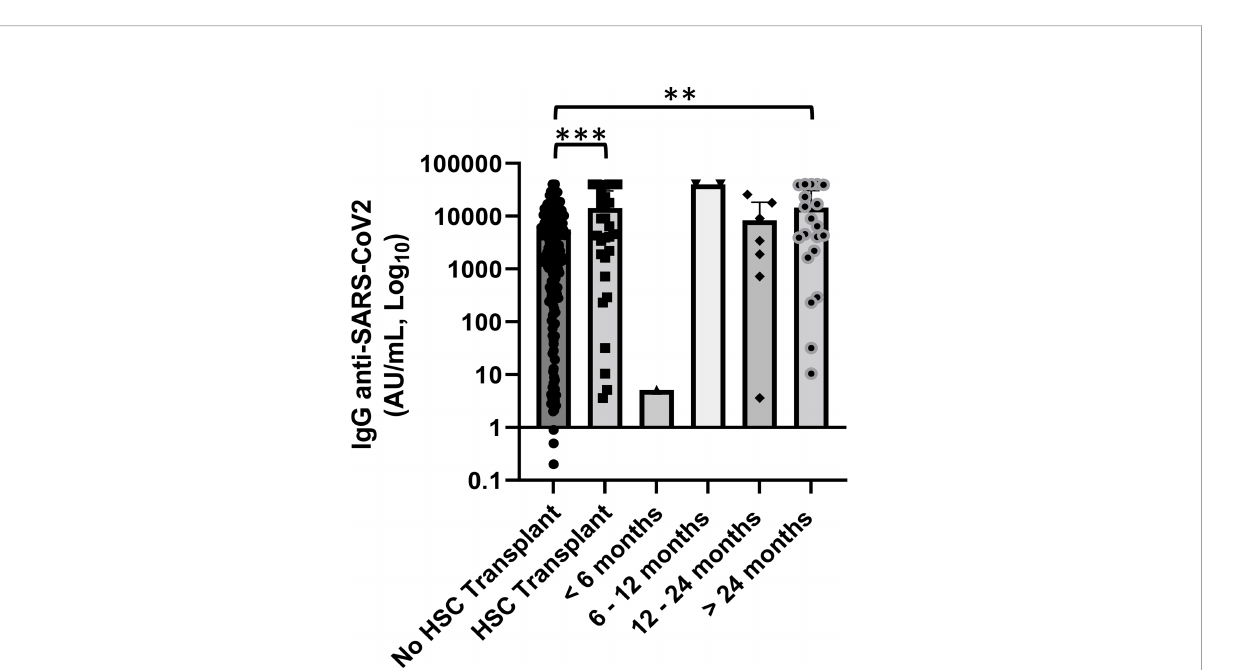
FIGURE 6 Association of anti-SARS-CoV2 IgG concentrations with hematopoietic stem cell (HSC) transplant and distance from day 0 of infusion. Patients who received an HSC transplant showed a signi fi cantly lower level of anti-SARS-CoV-2 IgG than patients who did not perform (p < 0.001). Differences assessed by one-way ANOVA test (p < 0.001), Bonferroni post-hoc test: (***) p < 0.001. Statistical analysis was not done for groups of patients with a median follow-up since day 0 of infusion <12 months because of small number of cases. Error bars correspond to standard deviation calculated from the mean of relative concentrations. Values below the black line correspond to anti-SARS-CoV-2 IgG lower than 10.0 AU/ml, and values of 0 AU/ml were not shown since the graph is on a log scale.